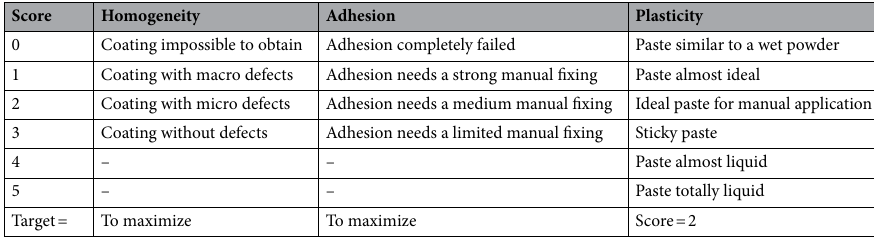
Table 3. Panel test evaluation and target for the response